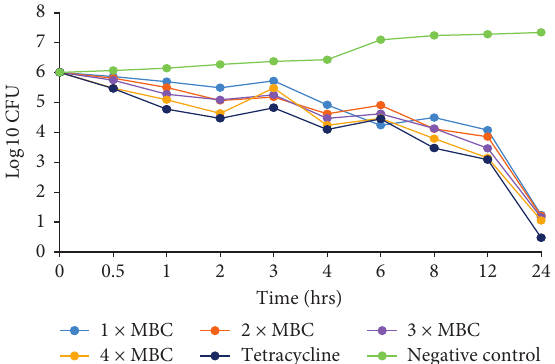
Figure 5: Time-kill kinetics activities of the dichloromethane: methanolic extract of C. asiatica against S. aureus .